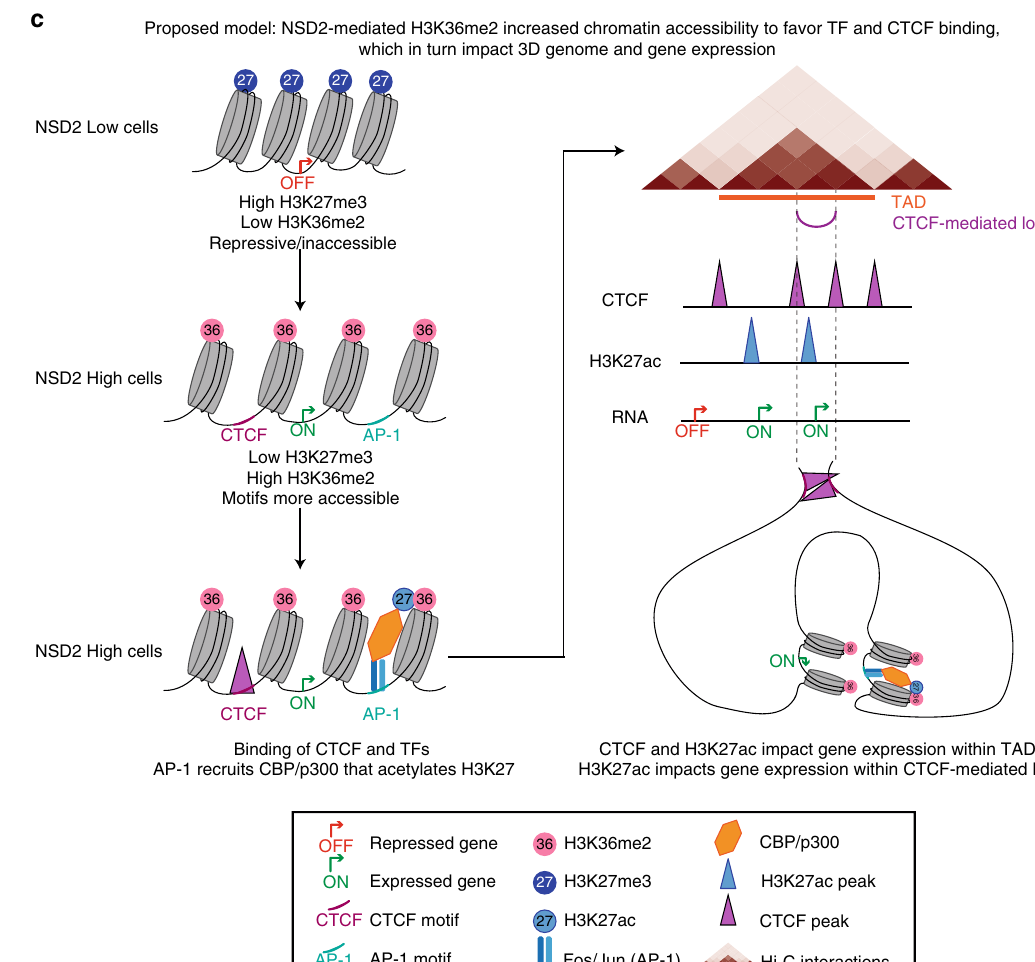
Fig. 7 Changes in gene expression occur as a function of changes in chromatin in TADs and CTCF loops. a Logistic regression model of gene expression changes as a function of CTCF and/or H3K27ac changes in TADs and CTCF loops (see the “ Methods “ section for details). Diff. CTCF and H3K27ac: differential CTCF and H3K27ac peaks. DE gene: differentially expressed gene. P -values were calculated using Wald-test (*** P < 2e − 16 for differential CTCF in TADs; *** P = 2.6e − 5 for Diff. H3K27ac in TADs; NS P = 0.29 for Diff. CTCF in loops; *** P = 1.38e − 6 for Diff. H3K27ac in loops). b Intersection of differential CTCF and H3K27ac peaks within TADs and CTCF loops. c Proposed model: NSD2-mediated H3K36me2 increases chromatin accessibility to favor TF and CTCF binding, which in turn impacts 3D genome reorganization and gene expression